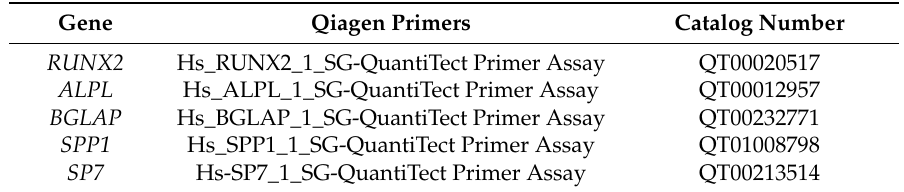
Table 2. Qiagen gene primers specific for osteogenic differentiation or involved in the differentiating process. Their expression was normalized to the b-actin housekeeping gene (Table